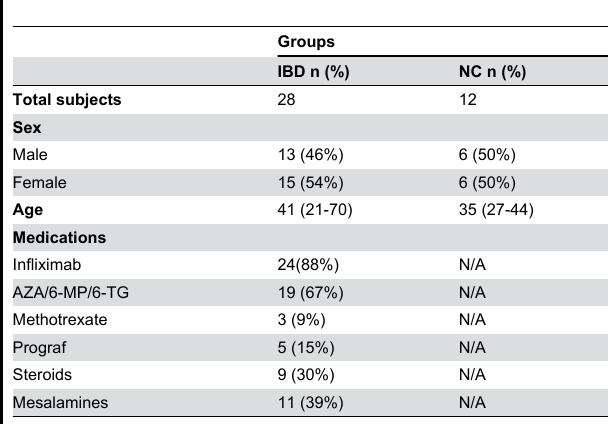
Table 1. Patient